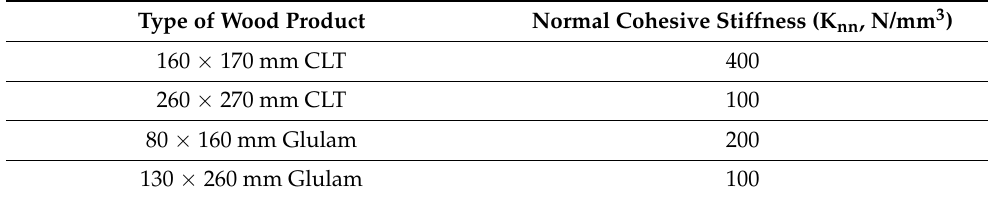
Table 13. Normal cohesive stiffness values. Type of Wood